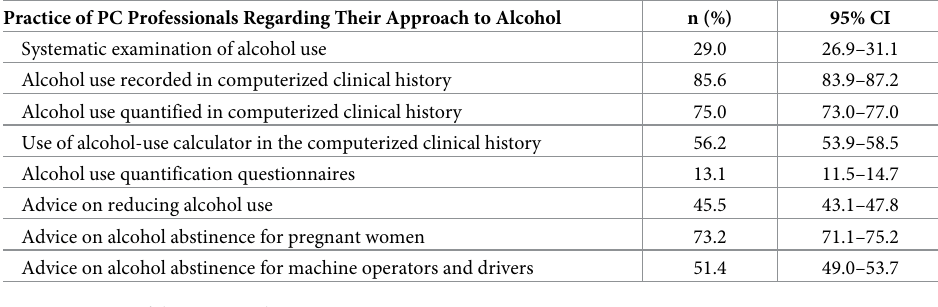
Table 4. Practice of PC professionals regarding their approach to